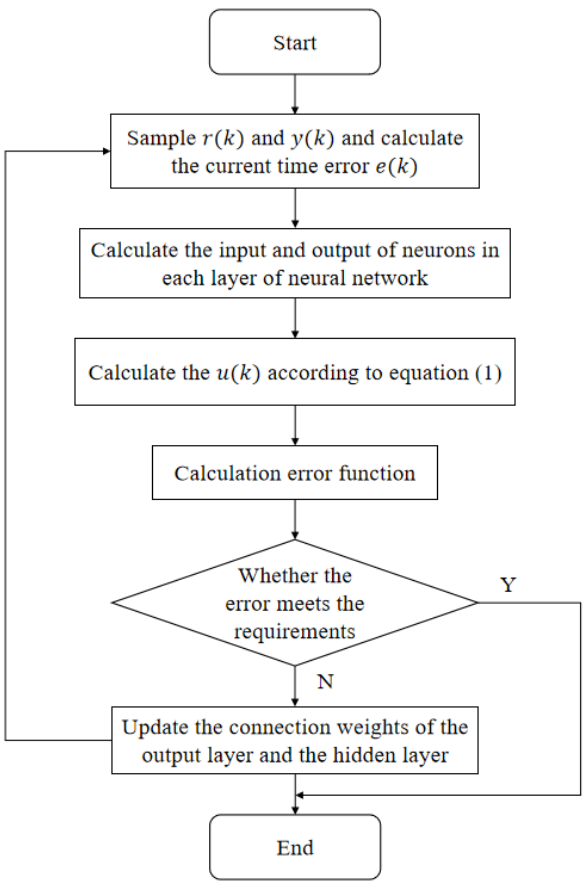
Figure 5. BP neural network algorithm process.